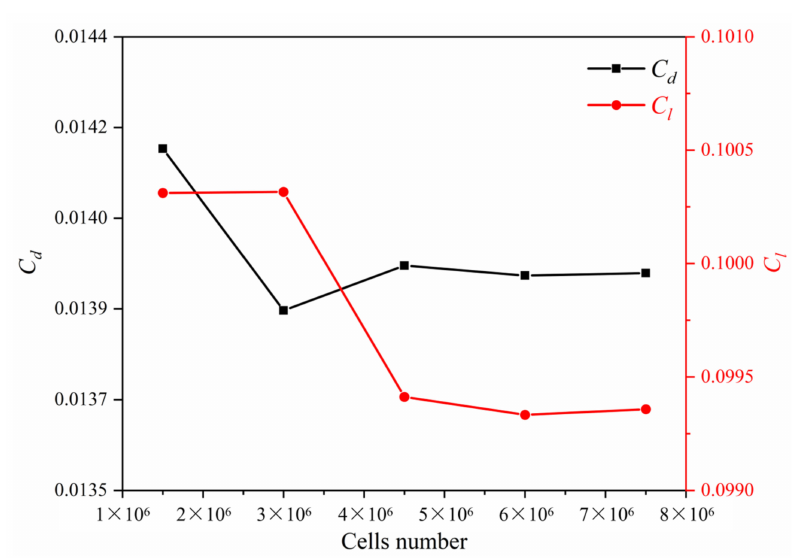
Figure 4. Structure grid of manta ray.